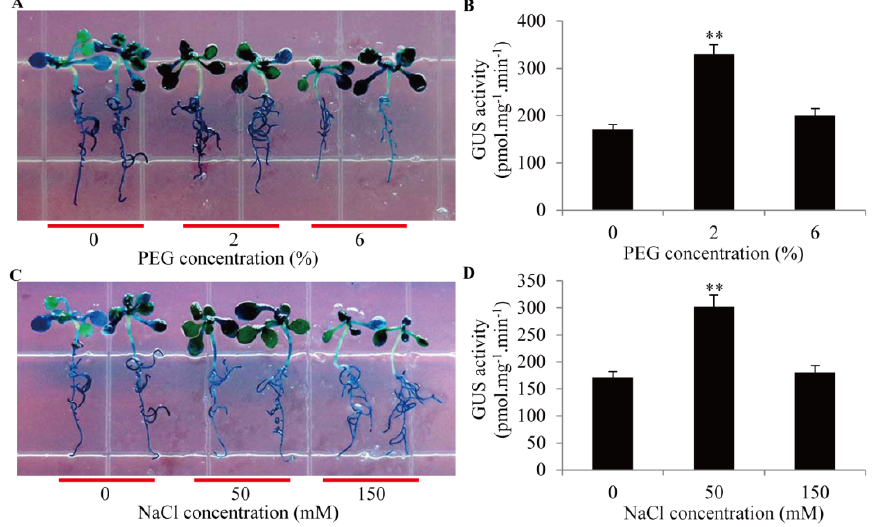
Figure 5. GUS activities of the GmTIP1;6 promoter under drought and salt stress treatments in transgenic Arabidopsis . ( A , C ) GUS staining for the proGmTIP1;6-GUS transgenic seedlings treated with 2–6% PEG6000 or 50–150 mM NaCl. ( B , D ) Activity analyses of GUS protein in transgenic seedlings under 2–6% PEG6000 or 50–150 mM NaCl treatment. ** indicated significant differences in comparison with the control treatment, p < 0.01 ( t -test).